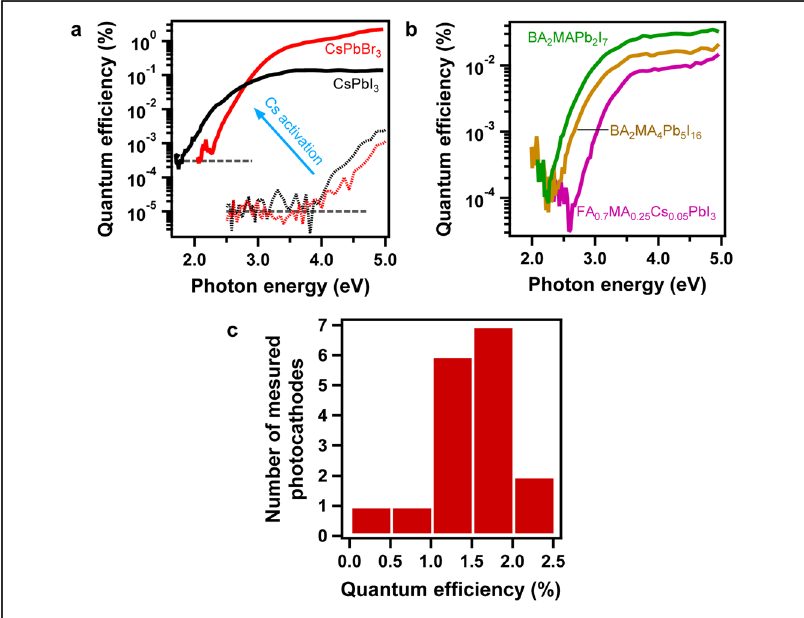
Fig. 2 Ef fi ciency of the photoelectric effect in halide perovskites. a Quantum ef fi ciency spectra of the photoelectric effect in the CsPbI3 and CsPbBr3 thin fi lms before (dashed lines) and after (solid lines) Cs activation. Dashed gray horizontal lines indicate the emission threshold. b Same for the hybrid perovskite fi lms: FA0.7MA0.25Cs0.05PbI3, BA2MA1Pb2I7, and BA2MA4Pb5I16. c Statistics of the maximum quantum ef fi ciency performance measured for seventeen CsPbBr3 thin fi lms.